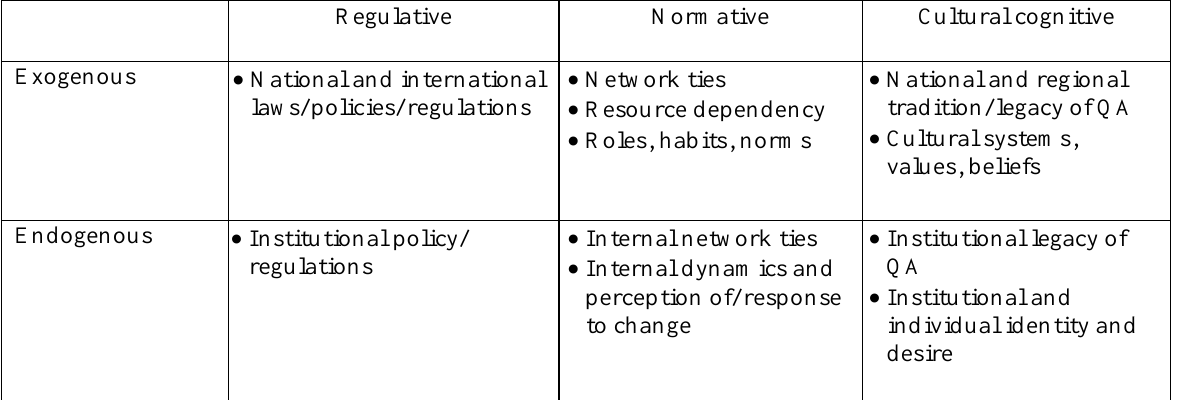
Table 1 An Institutional Framework for Drivers of Change Regulative